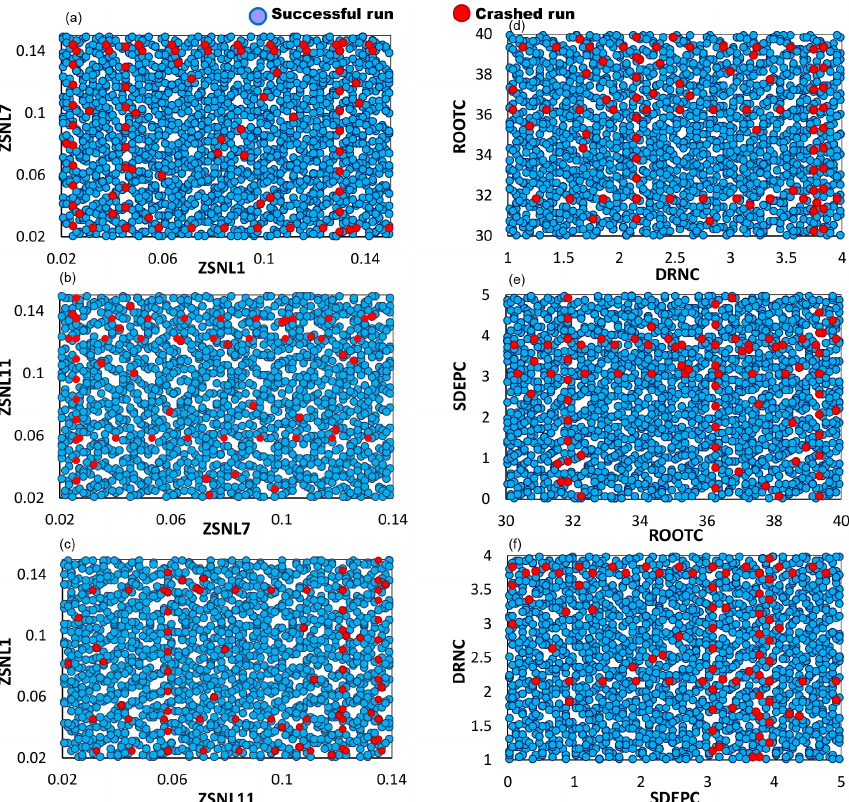
Figure 15. A 2-D projection of the MESH parameters for successful (blue dots) and crashed (red dots) simulations. Panels (a) , (b) , and (c) show the threshold snow depth parameters ZSNL , and (d) , (e) , and (f) show soil permeable depth ( SDEP ), maximum rooting depth ( ROOT ), and drainage index ( DRN ) for crop vegetation type